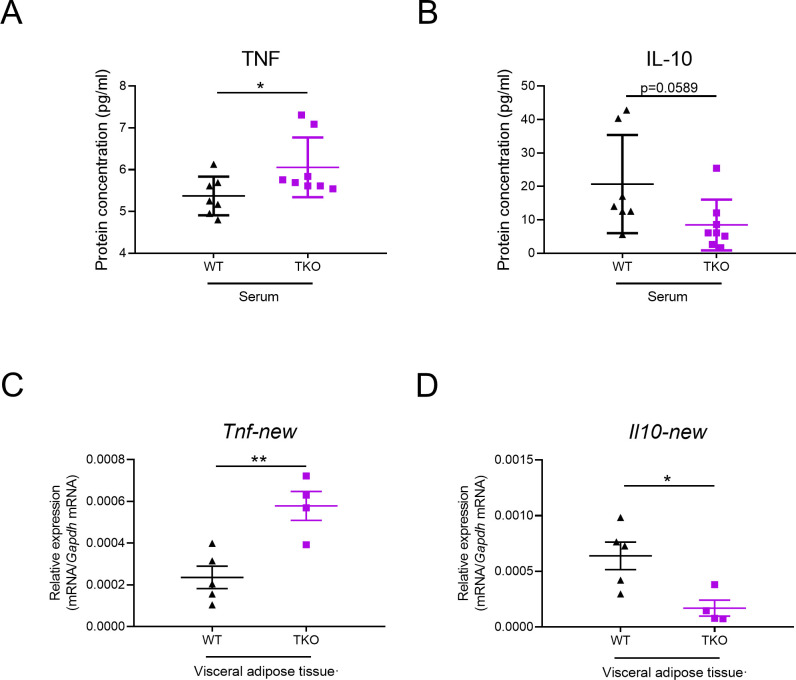
miR-17~92 family miRNAs inhibit TNF and promote IL-10 expression in adipose tissue.(A and B) Protein levels of TNF (A) and IL-10 (B) in serum of WT and TKO mice measured by ELISA. (C and D) qPCR analysis of Tnf (C) and Il10 (D) mRNA with additional primer pairs in WT and TKO adipose tissues. *p<0.05, **p<0.01 (unpaired Student’s t-test). Data are pooled from three (A–D) independent experiments (mean ± s.e.m.).